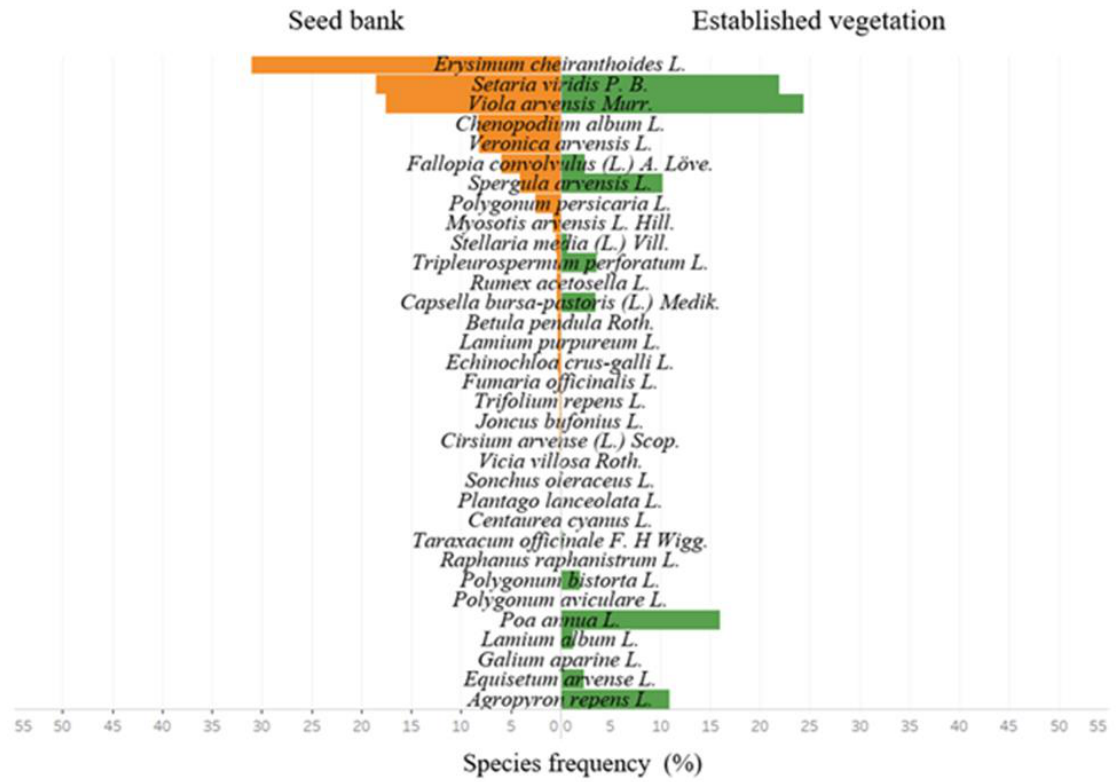
Figure 3. Percentage frequency of the species content of the seed bank in spring (left) and established vegetation in first assessment (right) in 2020 – 2021.